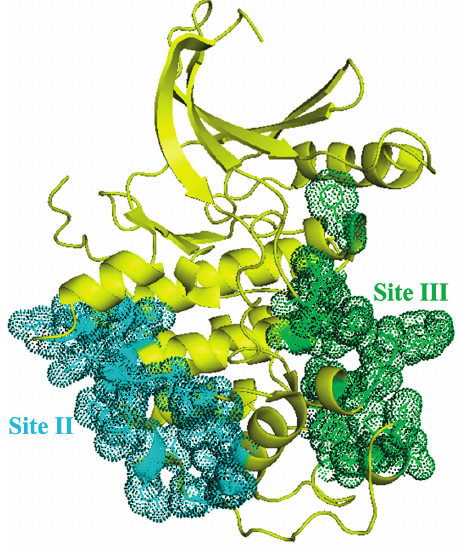
Figure 6. Non-competitive binding pockets of CDK2. Sites II and III are depicted in cyan and green, respectively. The amino acids in two pockets are provided in the